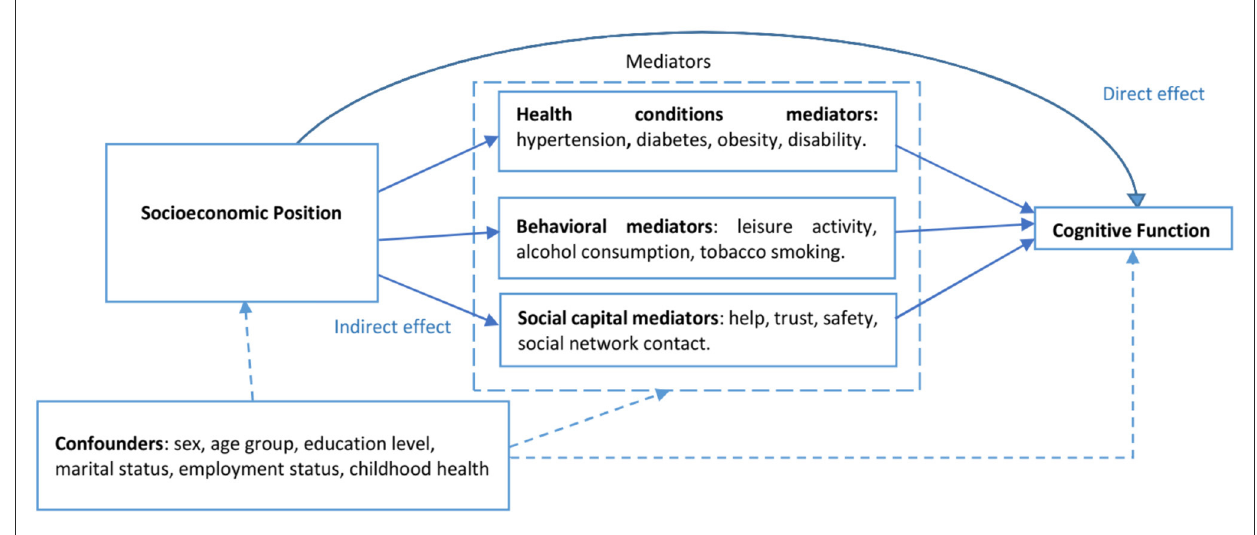
FIGURE1 Directed acyclic graph showing the hypothesized mediators in the association between socioeconomic position and cognitive function.